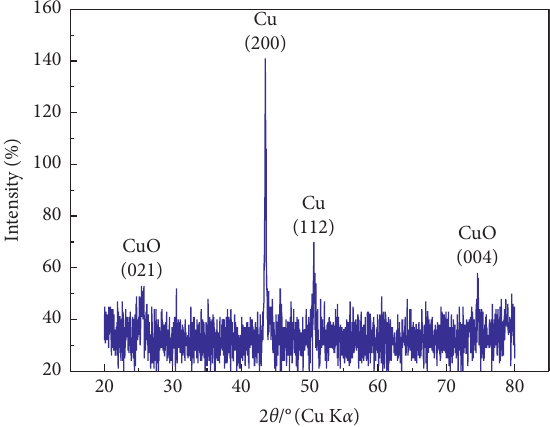
Figure 6: XRD pattern of the Cu-CuO/PANI/316L electrode.